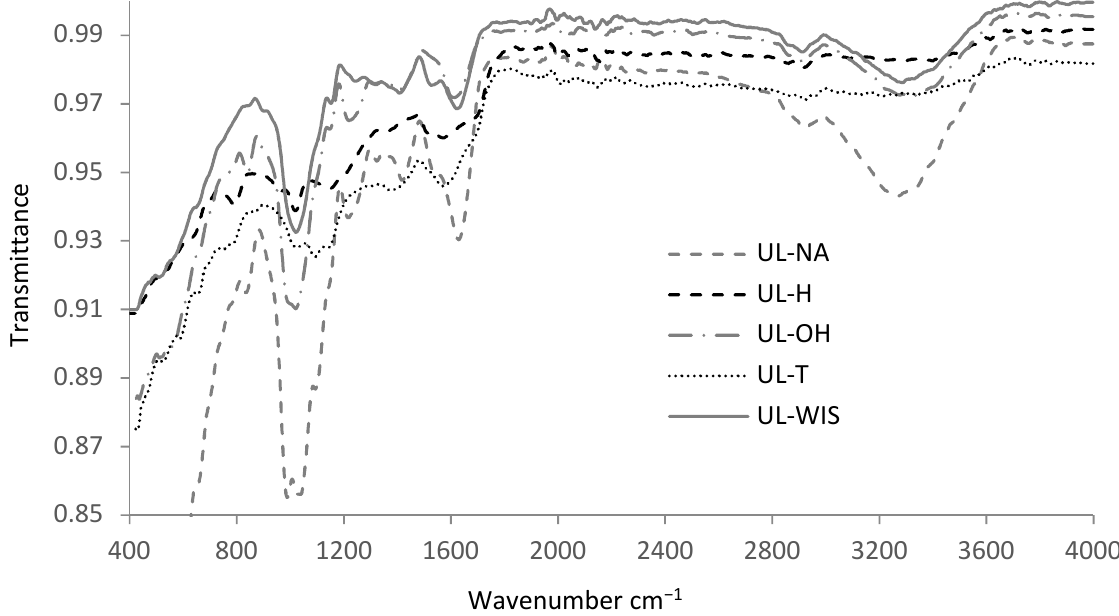
Figure 2. IR Spectra of the untreated (UL-NA), UL-WIS, and treated (UL-H, UL-OH, UL-T) dry U. lactuca before biosorption.